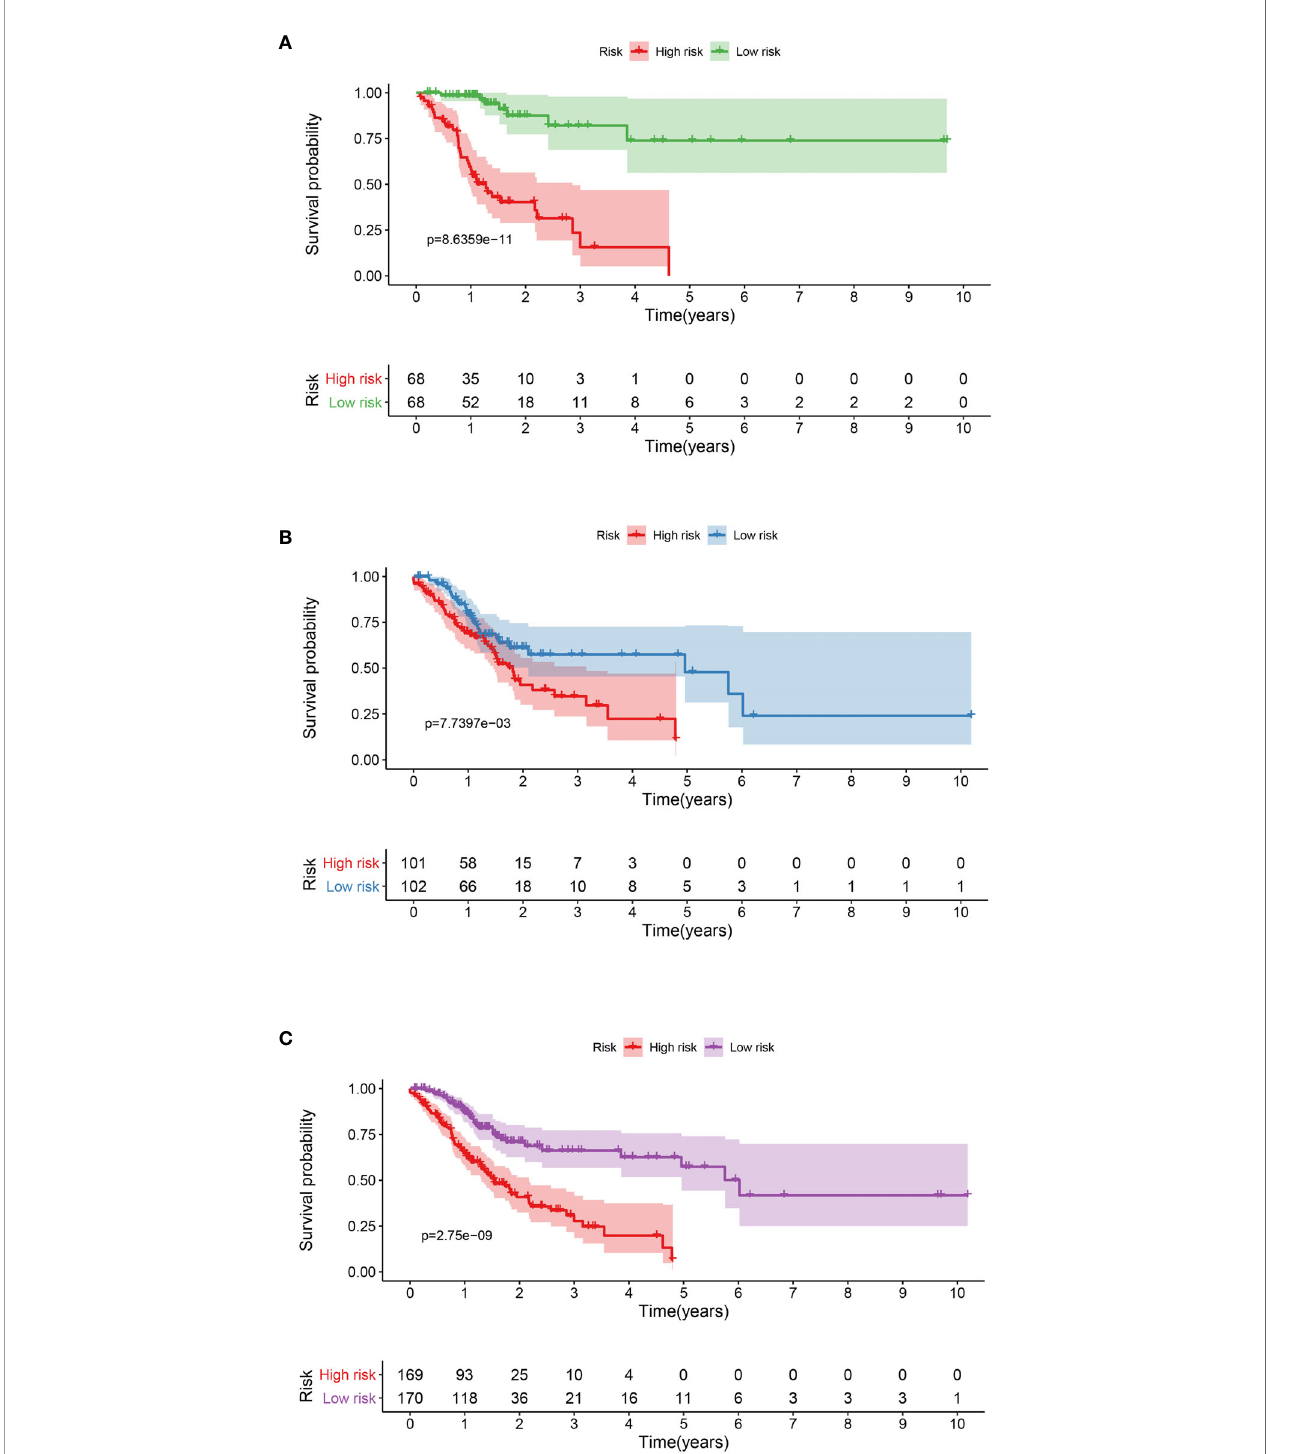
FIGURE 2 | Kaplan-Meier curve analysis between the high-risk group and low-risk group was performed in the training dataset (A) , testing dataset (B) , and complete dataset (C) ,